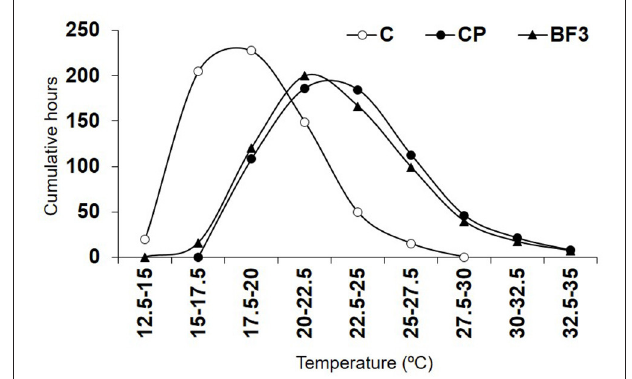
FIGURE 1 | Mean soil temperature at 20-cm depth during the biofumigation field experiment, expressed as cumulative hours at different temperature ranks. Control non-amended without plastic cover (C); control non-amended (CP); Brassica carinata pellets 3 tons ha − 1 (BF3). Values represent means of data collected from two sensors.